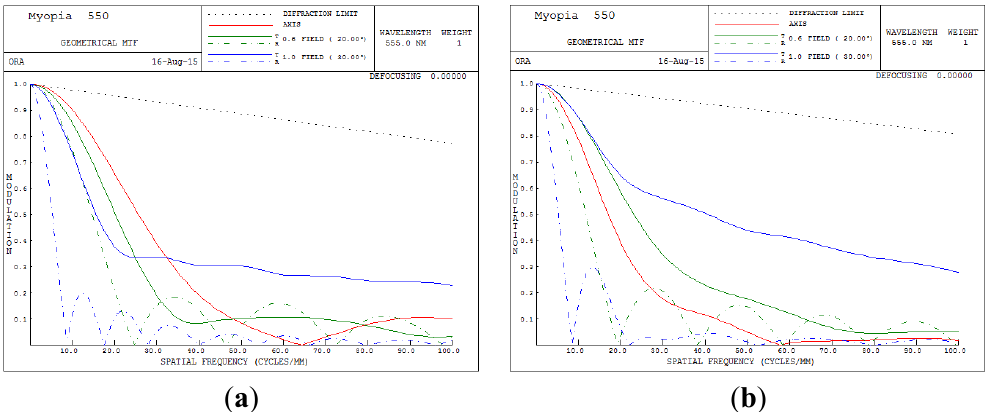
Figure 13. MTF plot obtained after applying the GA optimization method. ( a ) 5 mm; ( b ) 6 mm.